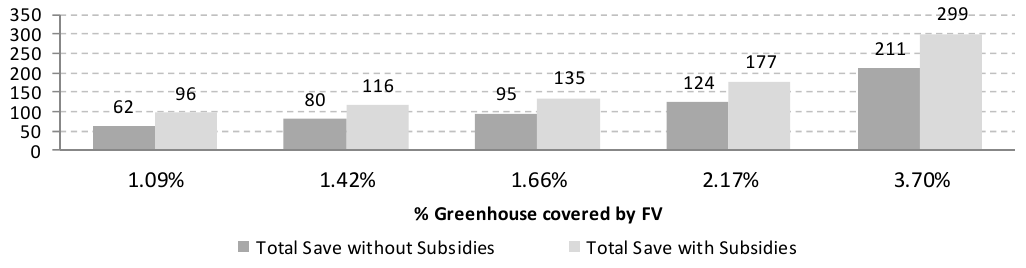
Figure 12. Savings (million € ) in horticultural sector in southeast Spain using PV systems.